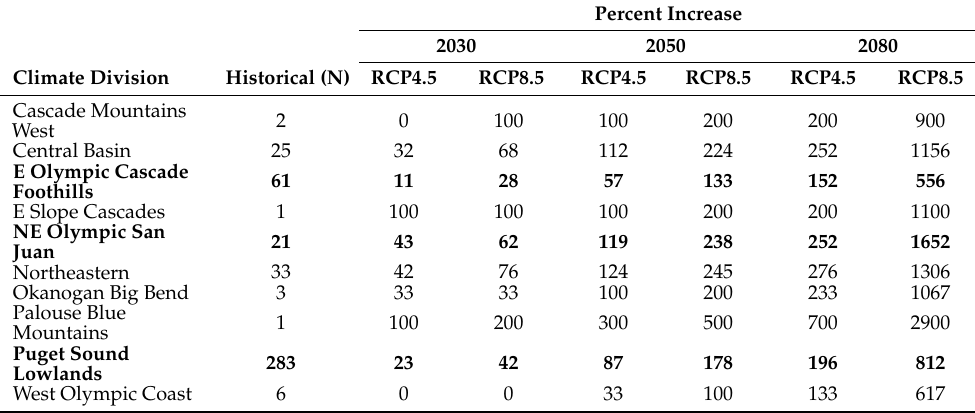
Figure 4. Spatial distribution of projected humidex anomalies. Columns denote RCPs: left is RCP4.5, right is RCP8.5; rows indicate years: top is 2030, middle is 2050, and bottom is 2080. Table 5. Number of deaths attributable to heat above the 99th percentile of humidex in the historical period and projected percent increase due to climate